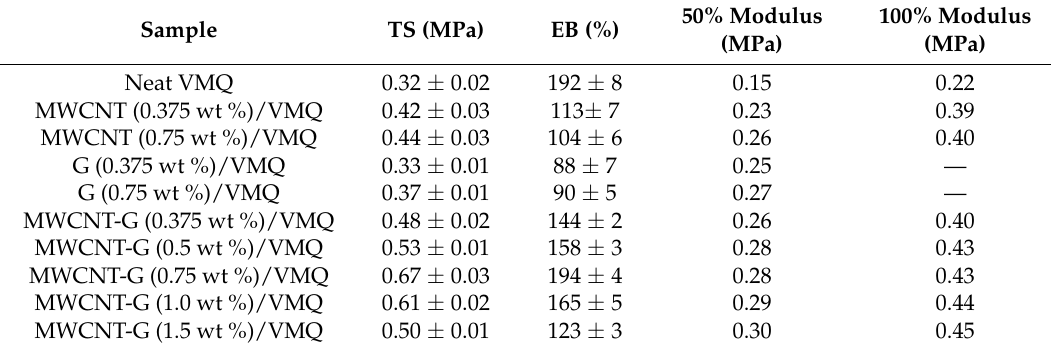
Table 10. Summary of mechanical properties of silicone rubber (VMQ) and its nanocomposites. Reproduced with permission from Wiley